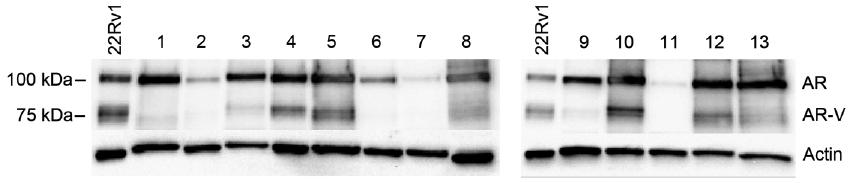
Figure 4. Western blot analysis of 13 patient samples showing representative expression patterns of the full length AR (110 kDa) and of LDB-truncated AR variants (AR-Vs) of about 80 kDa in CRPC bone metastases. Analysis was performed using an antibody targeting the N-terminal domain of the AR. The 22Rv1 cell extract was included as a positive control.